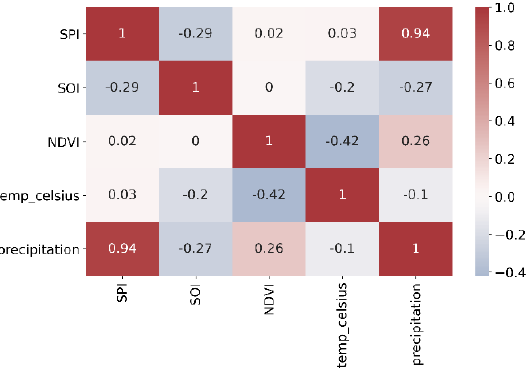
Figure 2. Correlation matrix. The Spearman correlation